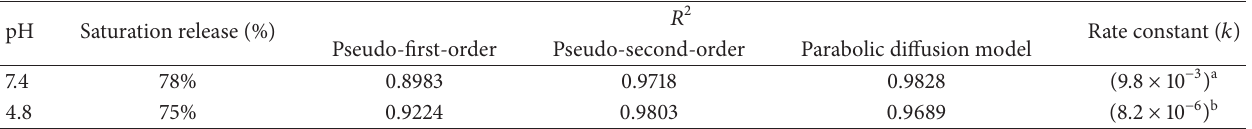
Table 1: Correlation coefficients ( 𝑅 2 ) and rate constants ( 𝑘 ) obtained by fitting the dopa release data for the coated nanocomposite in buffer solutions at pH 4.8 and 7.4.